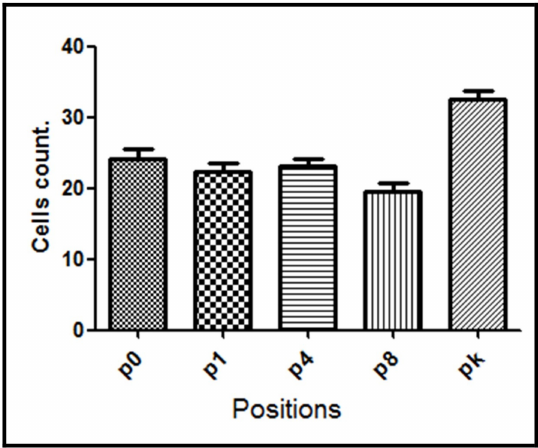
Figure 7. NF- κ B positive cell count for the G3 group evaluated at different positions from the bone lesion. The mean number with the corresponding standard deviation is shown for each point.